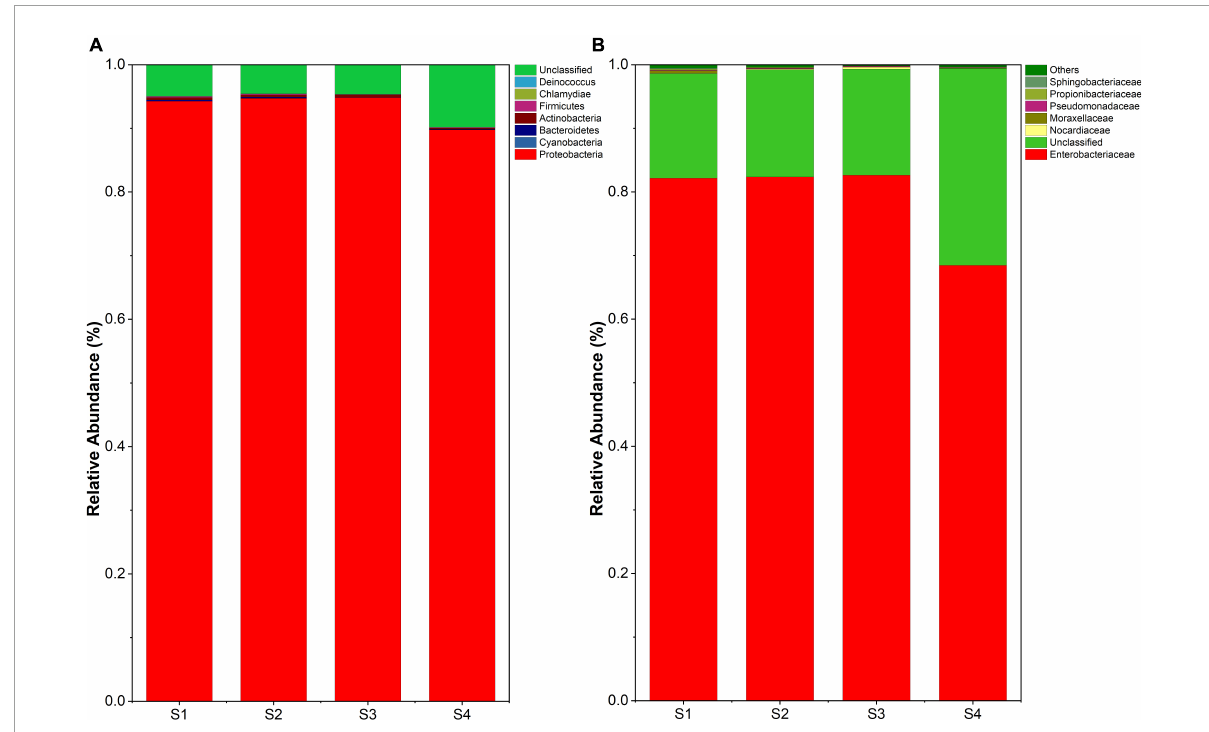
FIGURE3 (A) Endophyte composition in all samples at the phylum level. (B) Endophyte community composition at the family level.